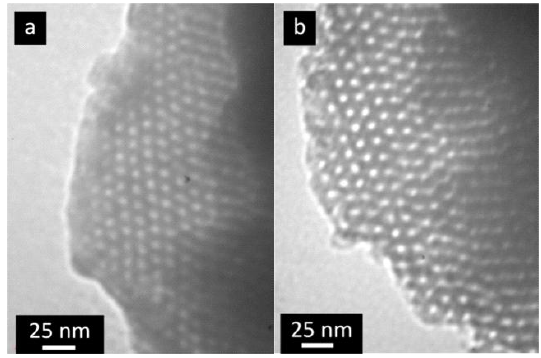
Fig. 3. TEM images of SBA-16 (a) V/SBA-16